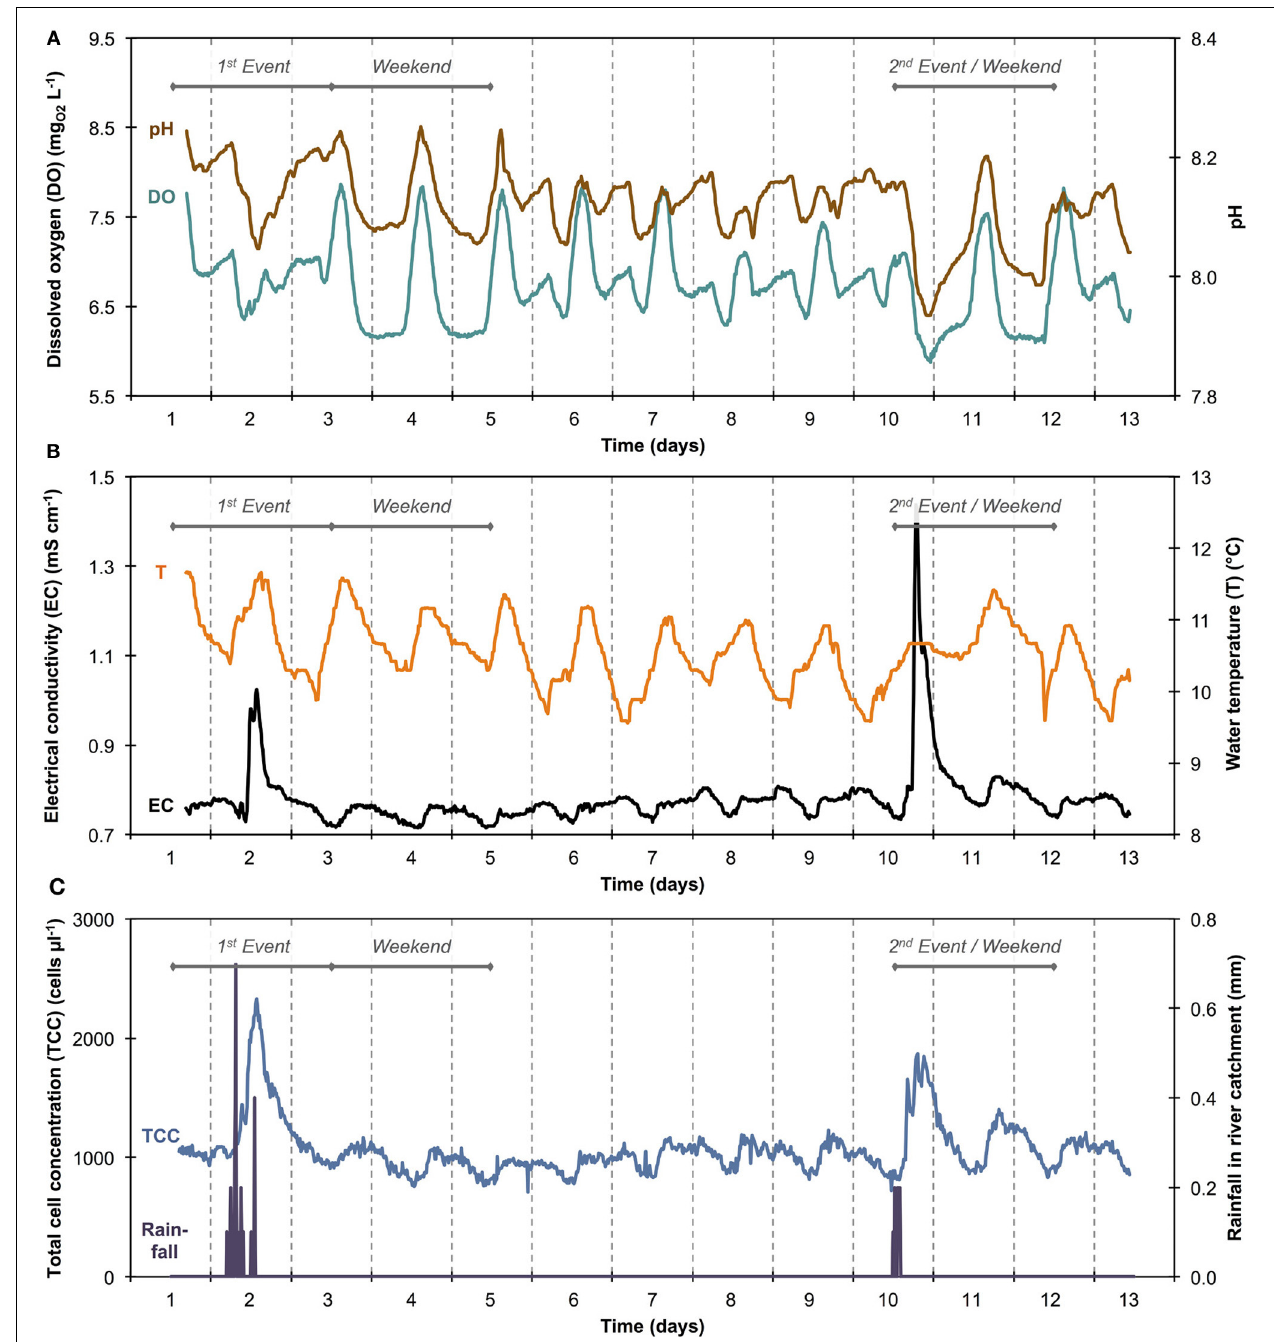
FIGURE 5 | Sensor data of river water for pH and dissolved oxygen (DO) (A) and electrical conductivity (EC) and temperature (T) (B). Total cell concentration (TCC) and rainfall data from Figure 3 are shown in simplified form (C) for easier and direct comparison with other sensor